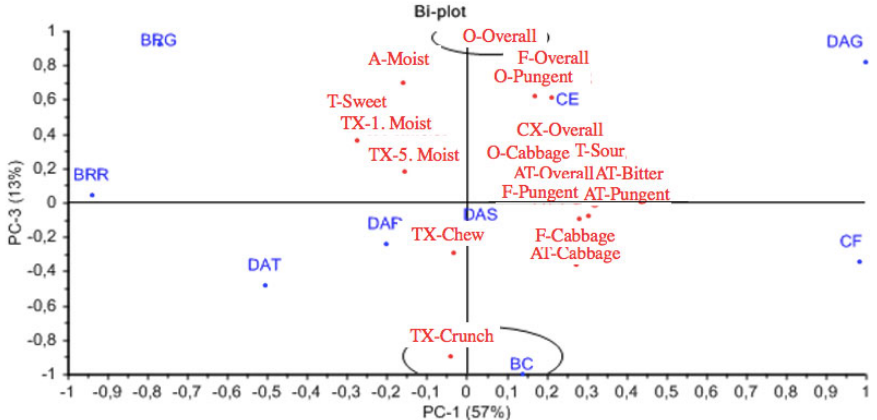
Figure 9. Bi ‐ plot of all samples, PC1 and PC3. Above celeriac are found the attributes F ‐ Overall and O ‐ Pungent, while below celeriac are clustered the following: F ‐ Pungent, AT ‐ Overall, AT ‐ Bitter, AT ‐ Pungent, O ‐ Cabbage, T ‐ Sour, T ‐ Bitter and CX ‐ Overall. Abbreviations of samples: BRG: Beet ‐ root grated, BRR: Beetroot round, BC: Broccoli, CF: Cauliflower, CE: Celeriac, DAG: Daikon grated, DAR, Daikon round, DAS, Daikon stick, DAT, Daikon triangle. Abbreviations of attributes: O: Odour, A: Appearance, TX: Texture, T: Basic Taste, F: Flavour, AT: Aftertaste, CX: